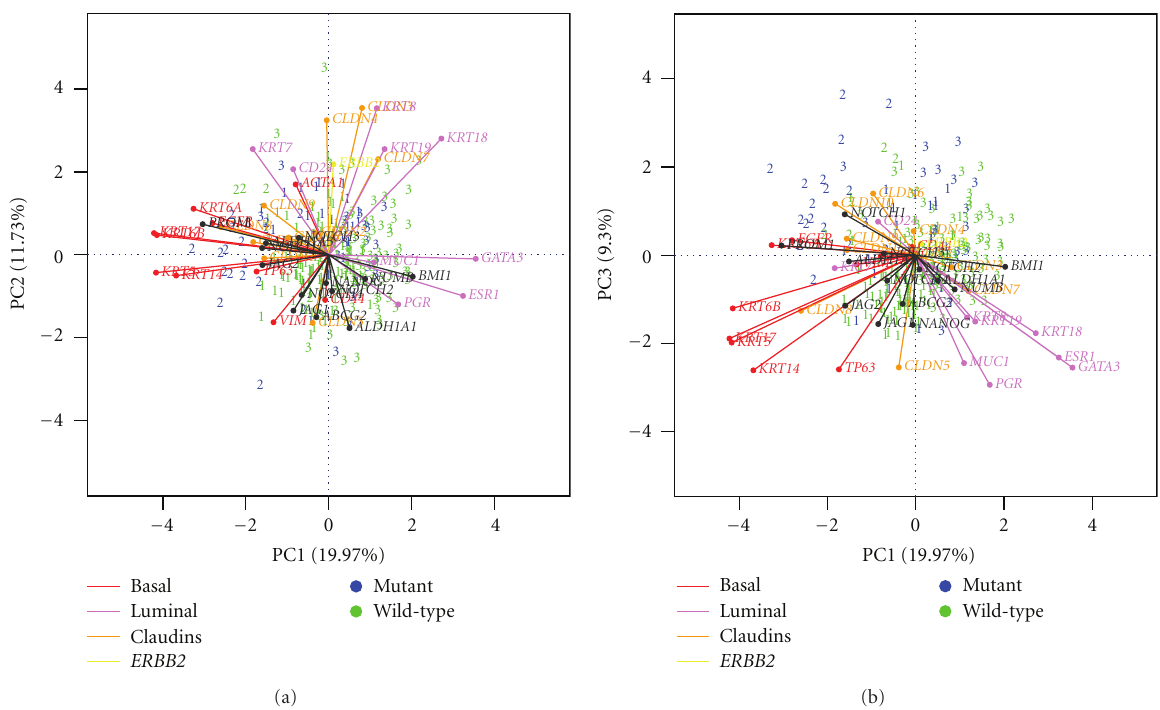
Figure 8: Passive projectionof stemlike-related genes in the space of the first two principal components (PC), (a), and in the space of first and third PCs, (b), of intrinsic phenotype gene set. Loading for EMT or stemlike genes are represented in